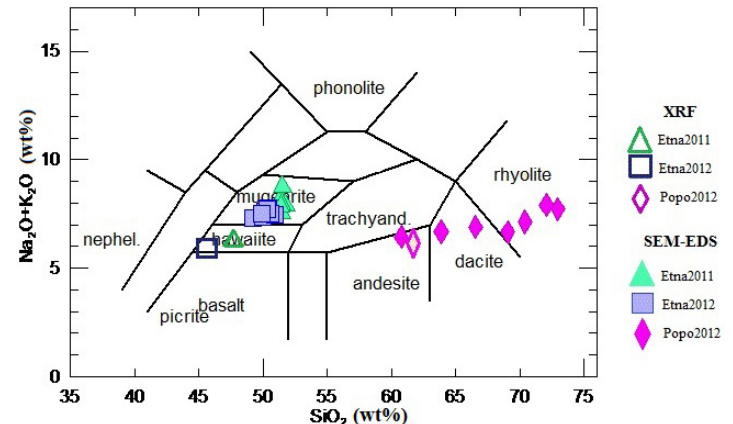
Figure 1. Total alkali vs. silica (TAS) diagram for bulk rock and glass analyses of Etna 2011, Etna 2012, and Popocatépetl samples.